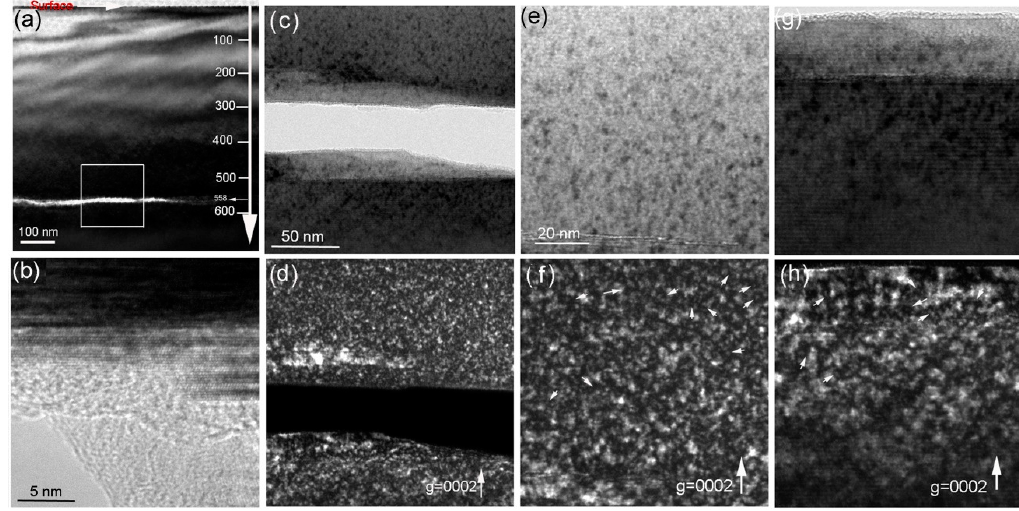
Figure 7. ( a ) Bright-field XTEM image showing the over-viewed damage distribution in the 194 keV H 2+ -implanted 6H-SiC at 900 °C. ( c ) BF image and ( d ) WBDF image under g = 0002 show the microstructure in the periphery of the microcrack. The magnified images taken from ( a ) show the lattice defects indicated by arrows above the microcrack presented in ( e , f ) and below the microcrack presented in ( g , h ). ( b ) HRTEM image shows the lattice fringe along the microcrack.